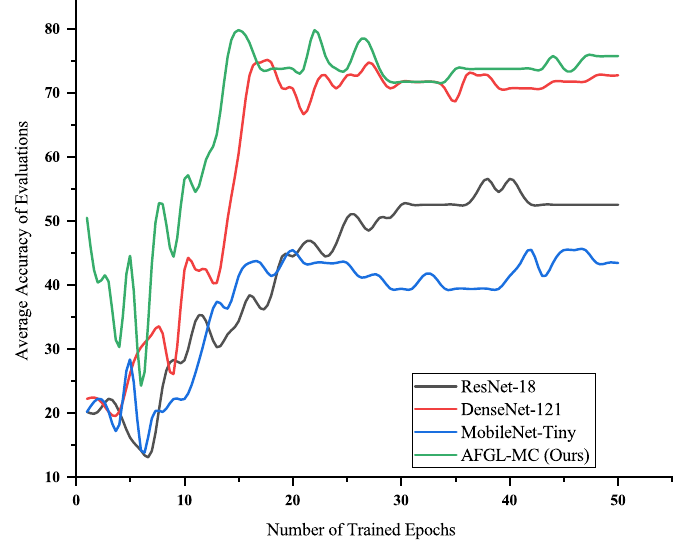
Figure 14. The evaluation results on FV benchmark.